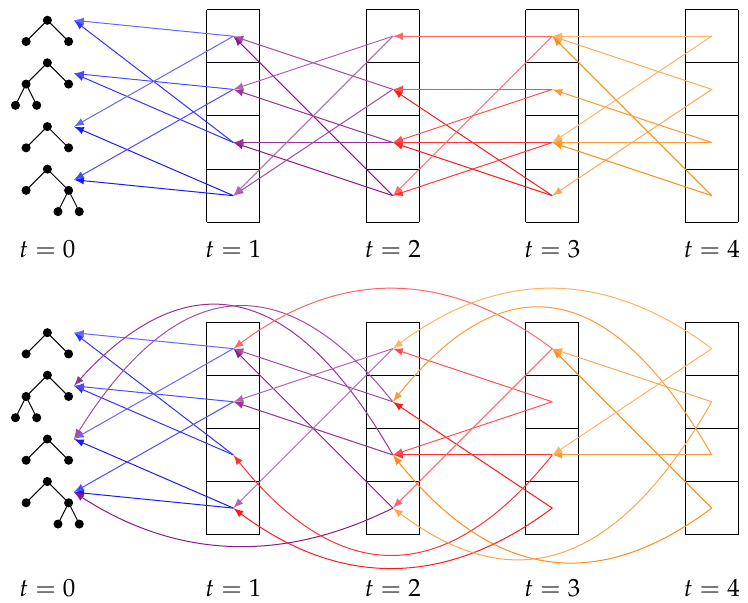
Figure 2. A visual representation of how GSGP can be implemented in an efficient way, sharing subtrees between individuals. At the top, the standard implementation where the parents can be selected only from the previous generation is shown. At the bottom, parents can be selected uniformly at random from the previous two populations. Notice how no additional storage is required.